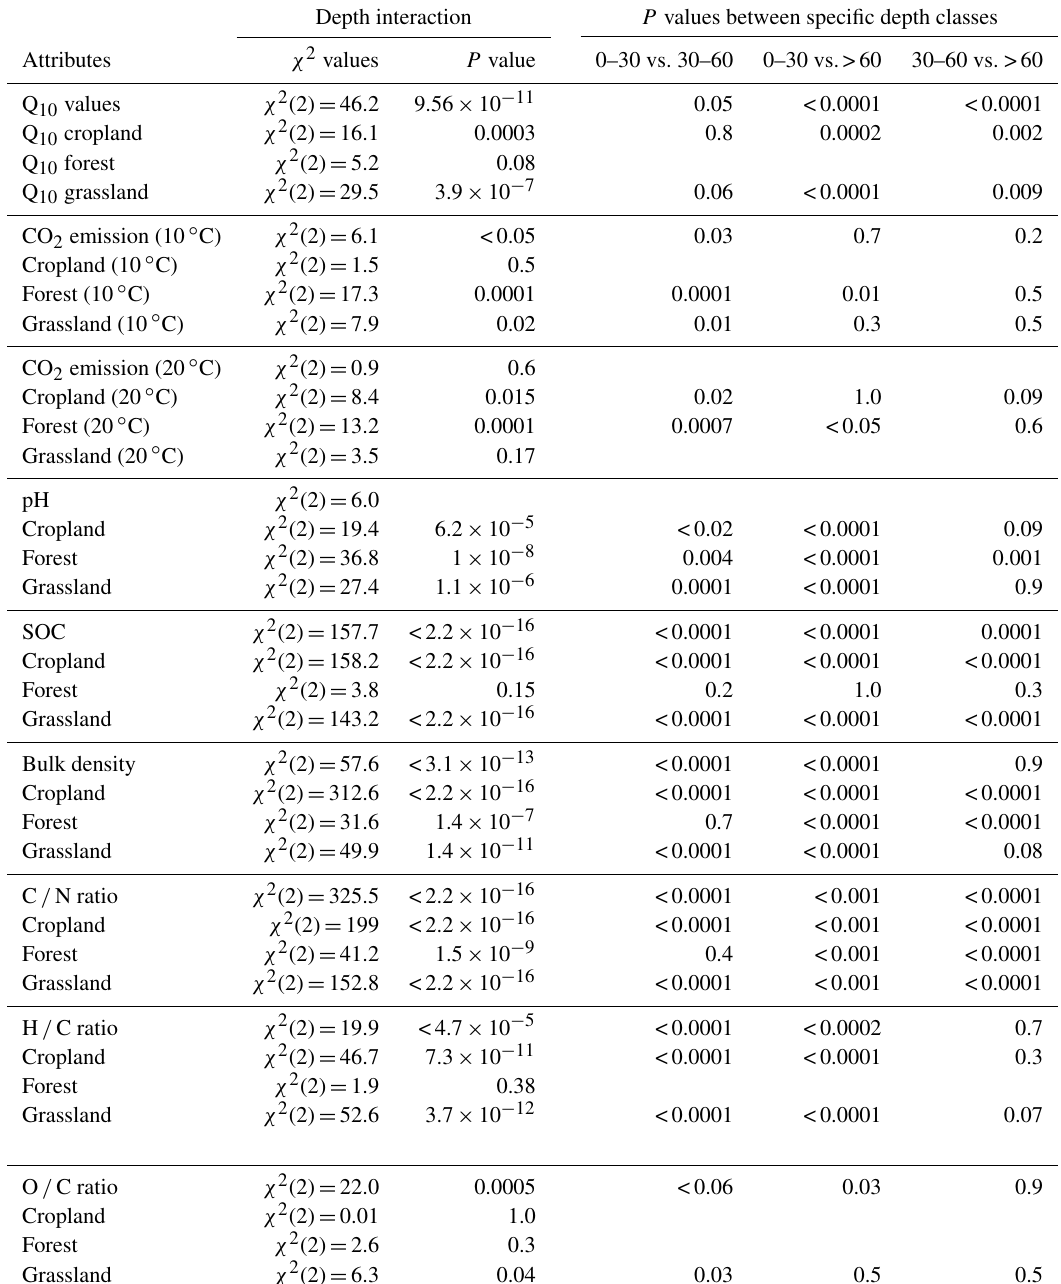
Table 3. Results of the depth influence analysis displayed for Q 10 values, CO 2 emissions at 10 and 20 ◦ C, SOC contents, bulk densities, C / N ratios, H / C ratios and O / C ratios. Ea values (not shown) had similar significance to Q 10